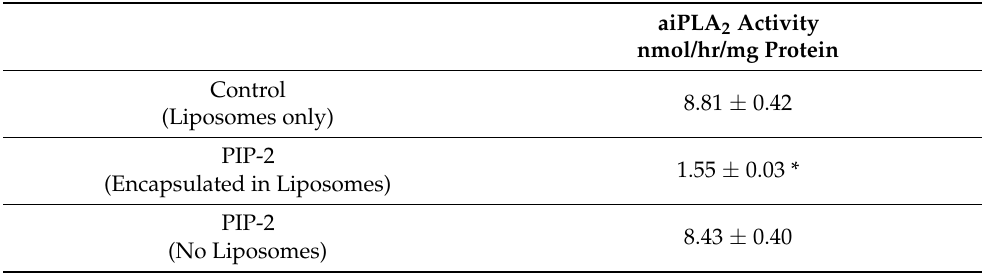
Table 1. aiPLA 2 activity of mouse lung after injection of PIP-2. Mice were anesthetized and injected intravenously with PIP-2 at 2 µ g/g body wt. Lungs were analyzed 2 h later for aiPLA 2 activity. Results are mean ± SD for n = 3. * p < 0.05 vs. Control and vs. PIP-2 mixed with phosphate buffered saline (no